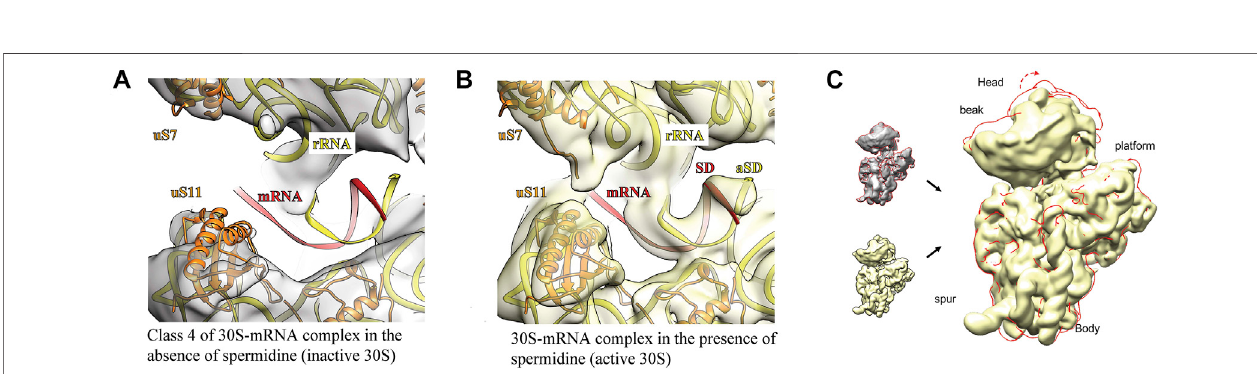
FIGURE 3 | Addition of spermidine helps to close the mRNA channel, allowing mRNA to fully accommodate in it. The ribosomal RNA is highlighted in yellow, ribosomal proteins – in orange and messenger RNA – in red. Forthe panel (A) the same atomic model wasused asfor panel (B) with additional processingin NAMDinator and re fi tting head and body parts separately. Panel (C) represents overlay of the 30 S-mRNA structures in the absence (grey + red contour) and the presence of spermidine (yellow). The 30 S head adopts open conformation (red contour, red arrow) in the absence of spermidine.